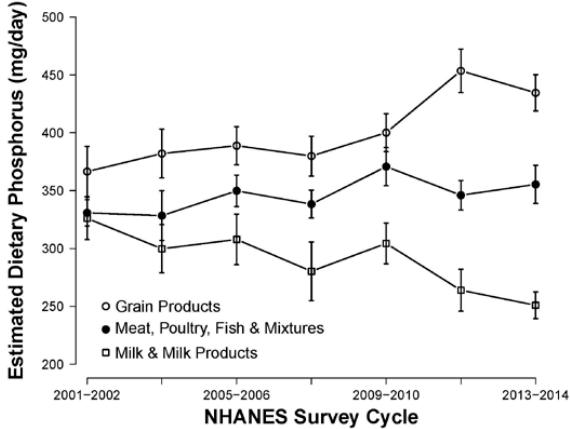
Figure 1. Estimated total dietary phosphorus contributed by the top 3 USDA food groups. Error bars represent a 95% confidence interval.